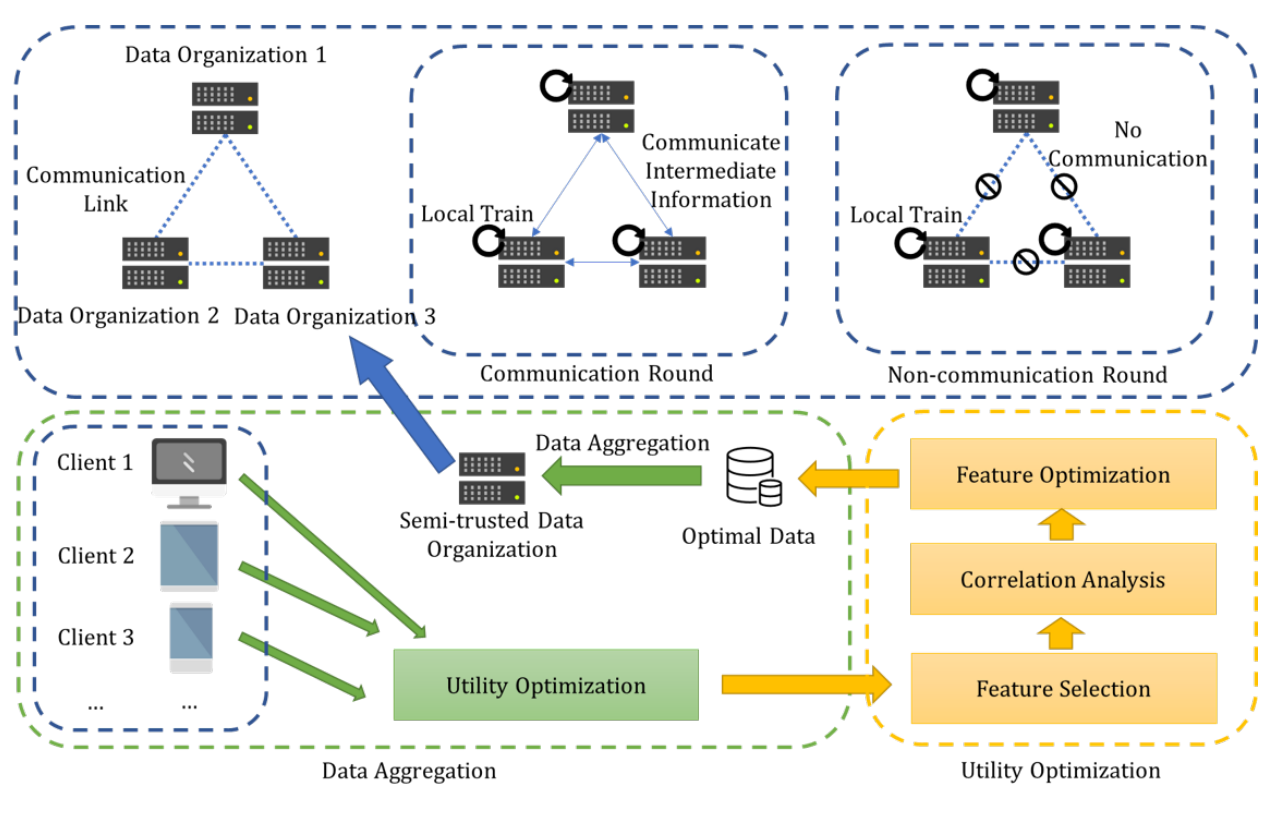
Figure 1. CRDP-FL